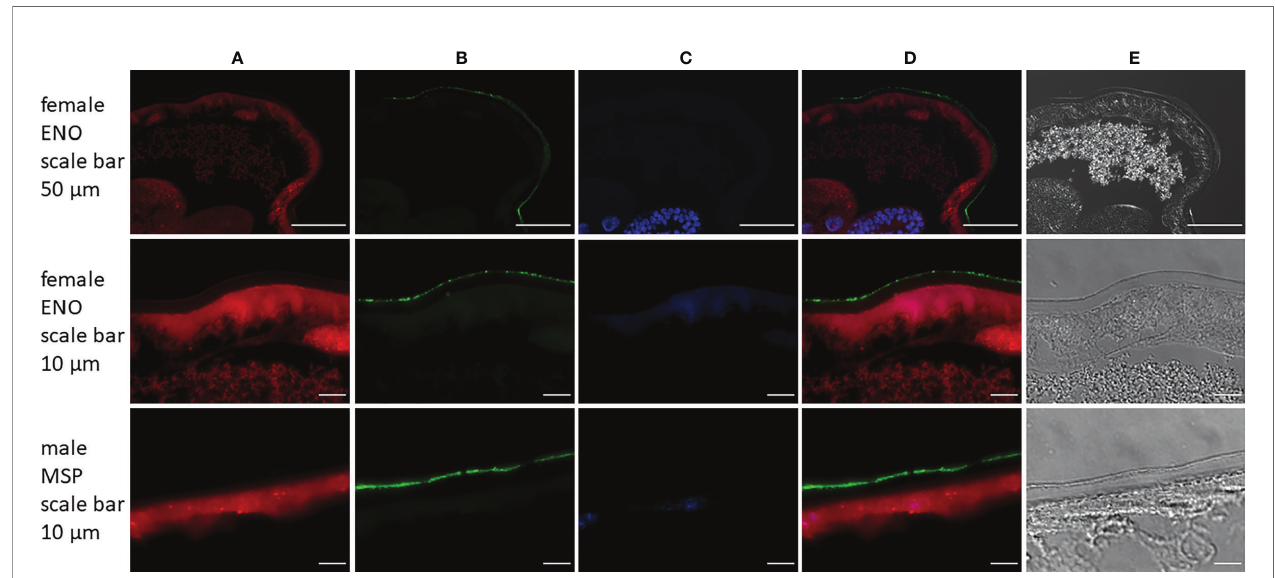
FIGURE 5 | Immunolocalization of enolase (ENO) and major sperm protein (MSP) in sections from Angiostrongylus vasorum females or males. Both enolase and major sperm protein [green, panel (B) ] are localized on the parasites surface. Actin fi laments [red, panel (A) ] were stained using phalloidin as a positive control; DNA [blue, panel (C) ] was stained with DAPI. Panel (D) is a merged image of panels (A – C) ; panel (E) displays transmitted light.